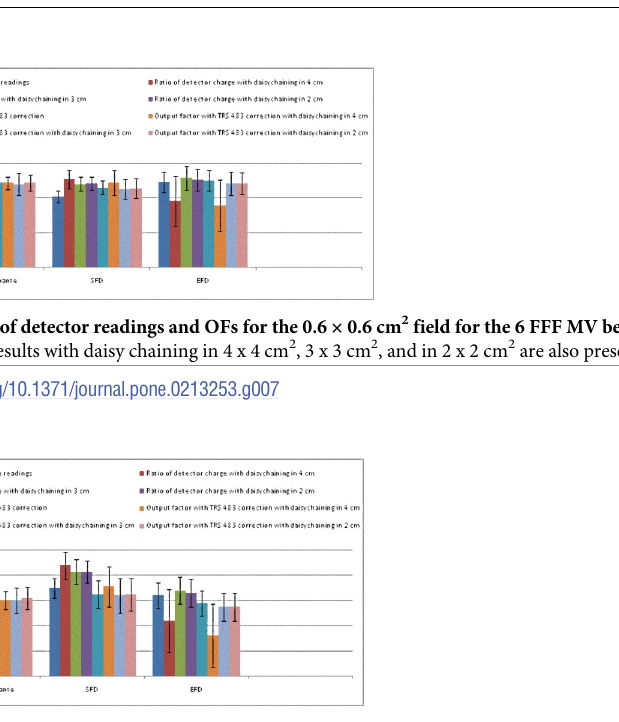
Fig 8. Ratio of detector readings and OFs for the 1 × 1 cm 2 field for the 6 FFF MV beams with different detectors. Results with daisy chaining in 4 x 4 cm 2 , 3 x 3 cm 2 , and in 2 x 2 cm 2 are also presented.